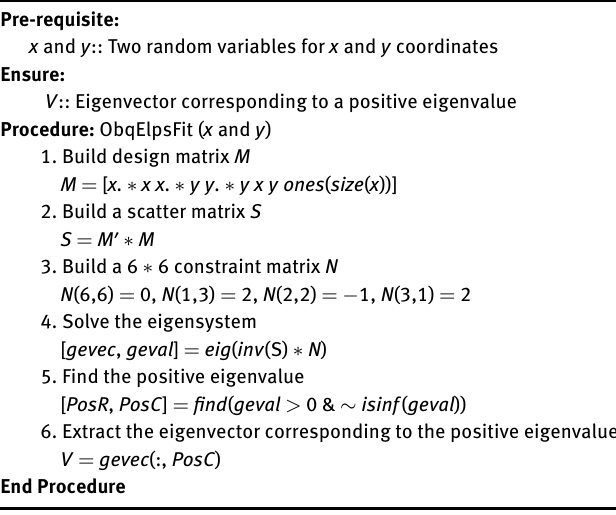
Algorithm 2: Oblique ellipse